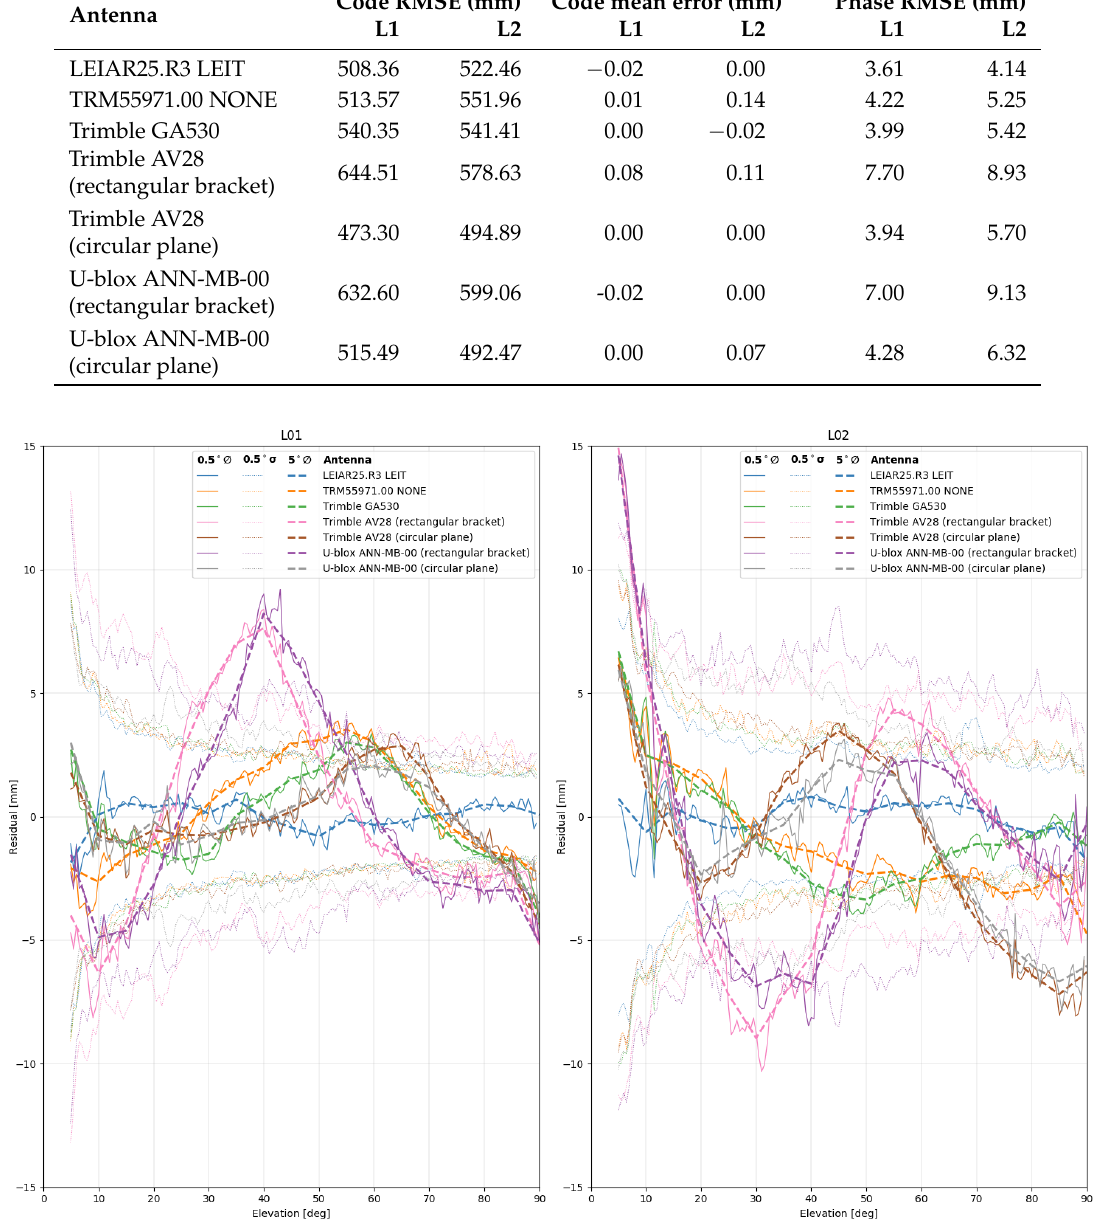
Figure 5. Elevation based antenna pattern on the phase residuals. L1 residuals are depicted left and L2 on the right. The continuous lines (0.5 ◦ ∅ ) show the mean residual over 0.5 degree elevation bins, the dotted lines (0.5 ◦ σ ) in the background its respective standard deviation and the dashed line (5 ◦ ∅ ) the smoothed 5 degree bins corresponding to the ANTEX